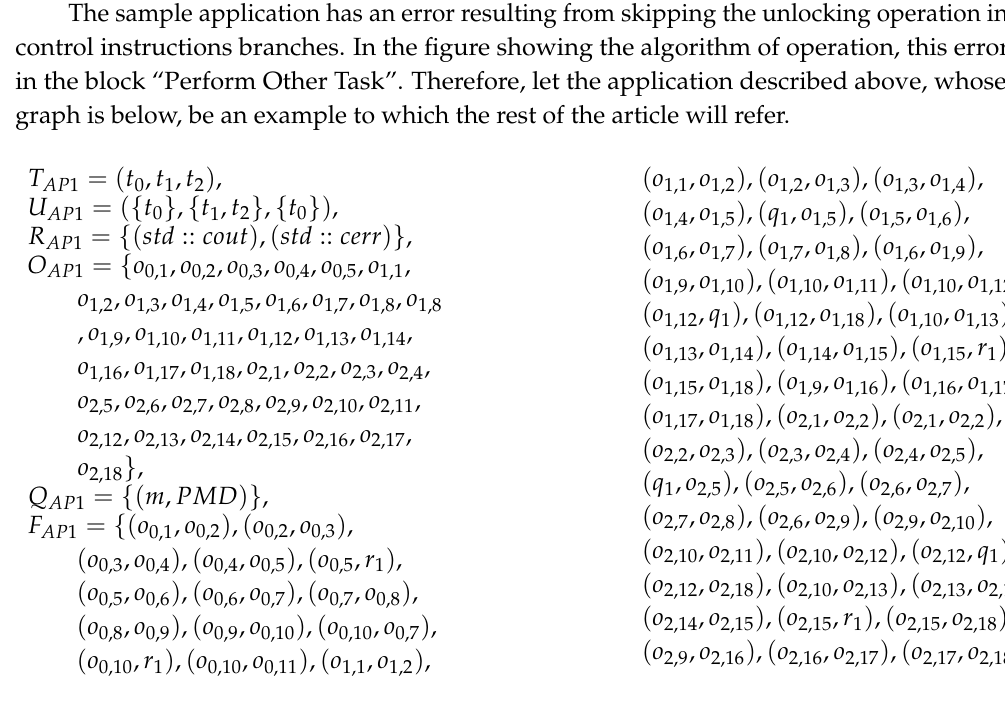
Figure 8. AP1 application operation